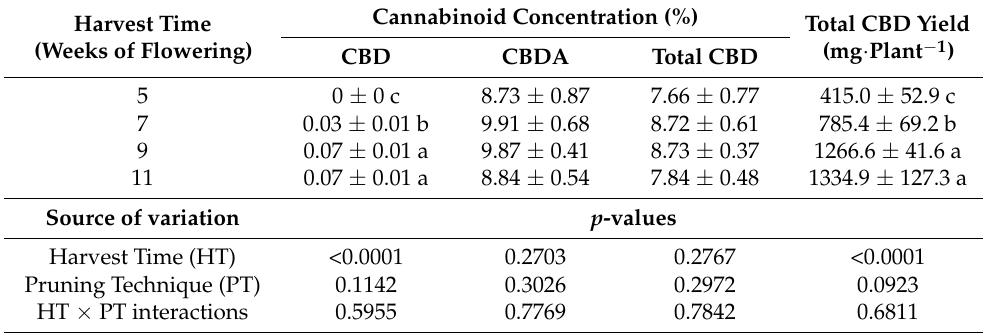
Table 1. Least square means ( ± standard error) of cannabinoid concentration (%) and total CBD yield (mg · plant − 1 ) for the four harvest times (weeks of flowering). Means with at least one identical letter are not significantly different from each other according to Fisher ´ s LSD test with α = 0.05. Values for CBDA and total CBD concentration are not significantly different from each other according to global F-test. Note that p -values correspond to F-test within an